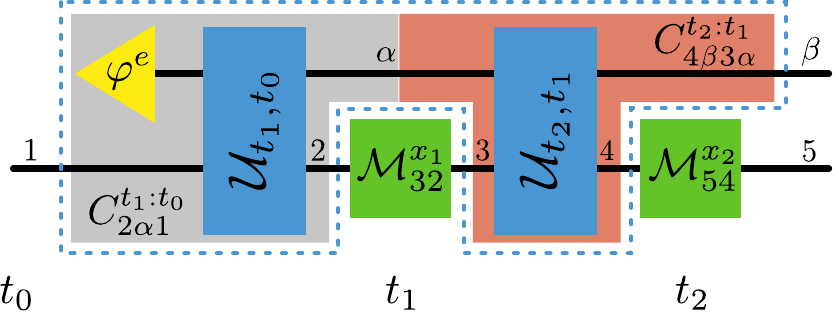
FIG. 11. Labeling of Hilbert spaces used for the comb description of Example 1. The grey box contains the comb C t 1 ∶ t 0 2 α 1 and the red box the comb C t 2 ∶ t 1 4 β 3 α . The comb C t 2 ∶ t 1 ∶ t 0 4 β 321 corresponds to everything inside the dashed box and consists of the contraction of the two combs C t 1 ∶ t 0 2 α 1 and C t 2 ∶ t 1 4 β 3 α